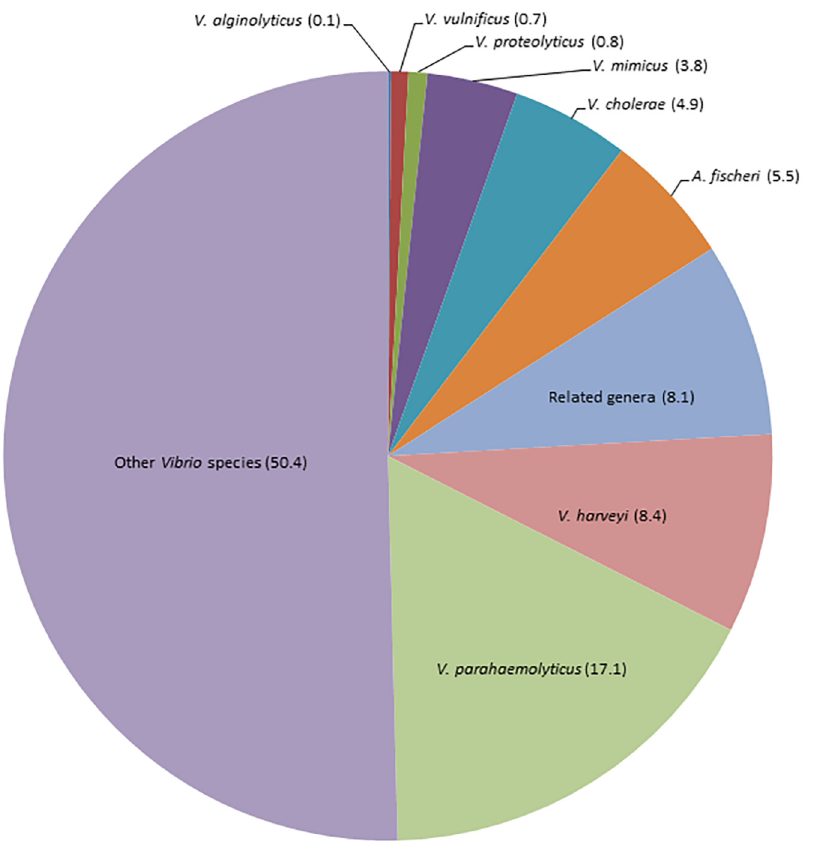
Fig 4. Prevalence of Vibrio spp in coastal lagoons of the Yucatan